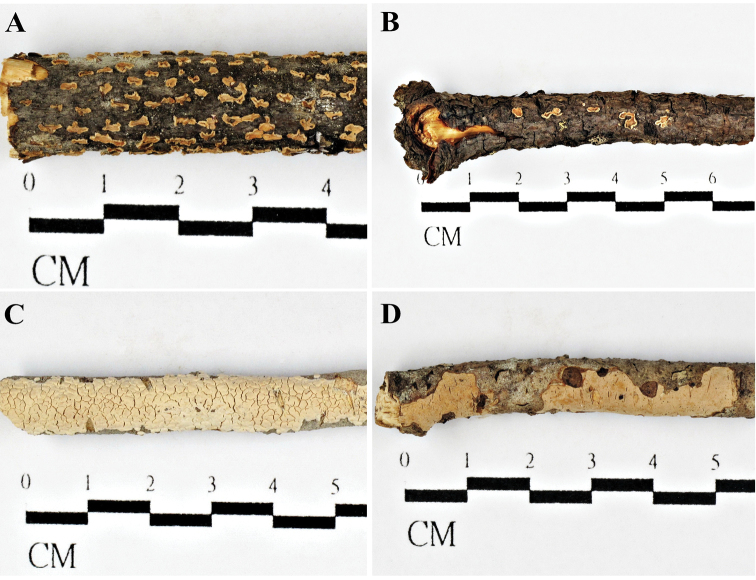
Basidiocarps AAleurodiscusalpinus (holotype, Wu 1407-55) BA.pinicola (holotype, Wu 1308-54) CA.senticosus (holotype, Wu 1308-54) DA.sichuanensis (holotype, Wu 0010-18).